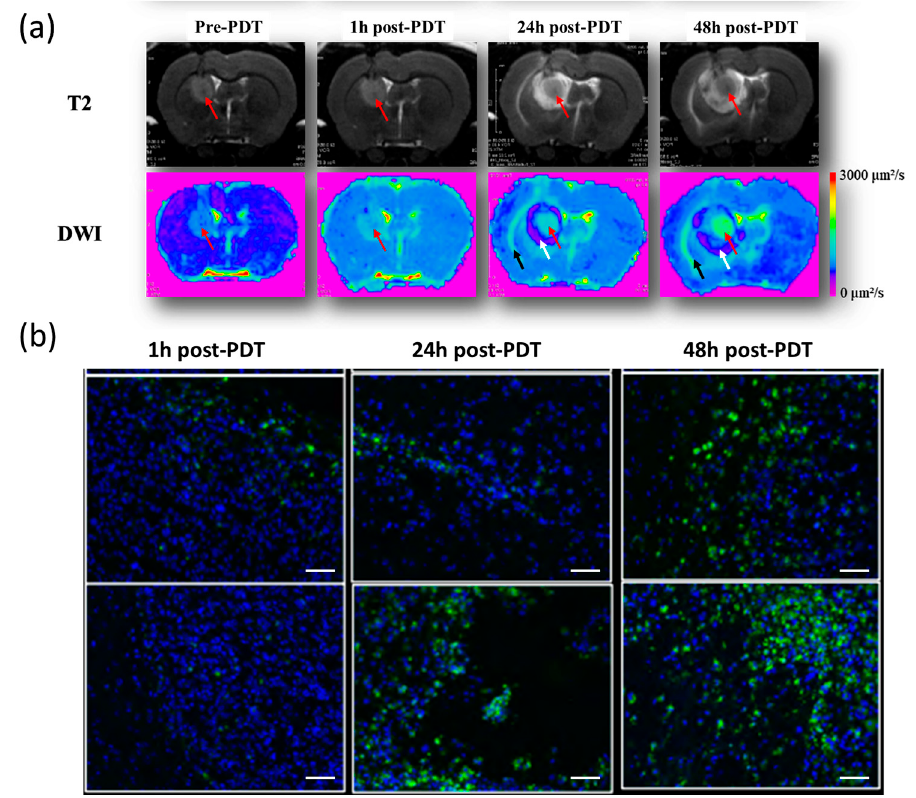
Figure 9. In vivo post-PDT inflammation. ( a ) Rats treated by PDT after intravenous injection of AGuIX@PS@KDKPPR nanoparticles (1.75 µmol·kg − 1 porphyrin equivalent) and followed by MRI analysis via T2 anatomical and diffusion (DWI—diffusion-weighted imaging) sequences. Tumor indicated by a red arrow. On DWI, black and white arrows indicate the presence of vasogenic and cytotoxic edema, respectively. ( b ) Macrophage infiltration, demonstrated by immunofluorescence. Cell nuclei labeled with Hoechst (blue) and macrophages with CD-68 antibodies (green), ×20 (scale bars = 50 µm).